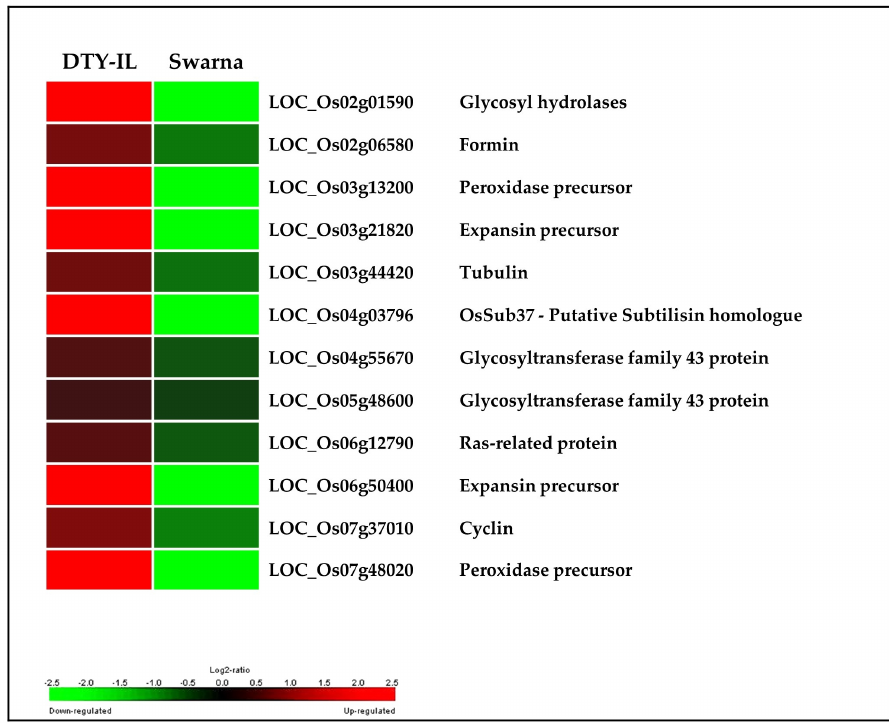
Figure 5. Enrichment analysis of the functional categories in FL-M14 and FL-M16. Over-represented Interpro domains and enriched pathways in FL-M14 ( A ) and FL-M16 ( B ) in flag-leaf under RDS. Top significant pathways and Interpro domains are shown in Y -axis with the number of represented genes on the X -axis.